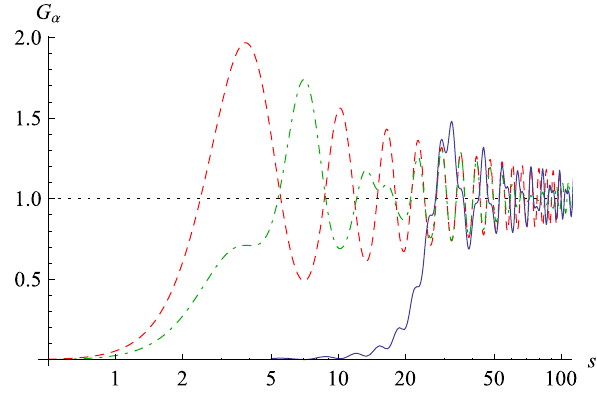
Fig. 2 s -dependence of crossover function (56) for several values of Coulomb parameter α . ( s scale is logarithmic.) Red dashed curve, α = 0. Green dot-dashed, α = 1. Blue solid curve, α = 10 [approaching the unit step function